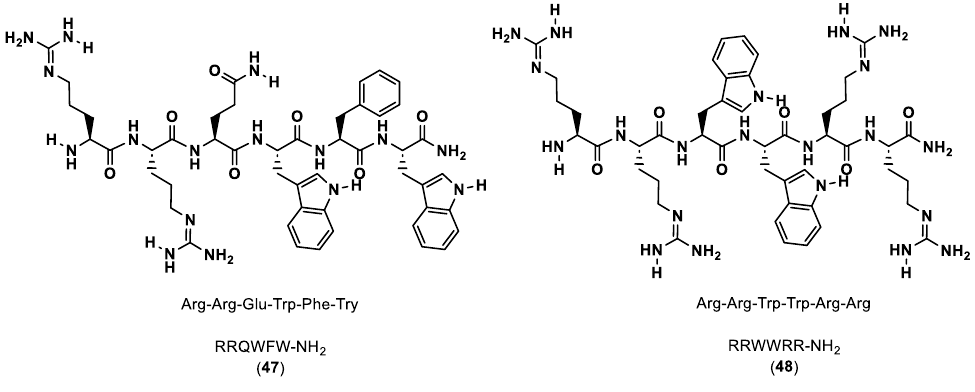
Figure 9. Sequence and structure of RRQWFW-NH 2 and RRWWRR-NH 2